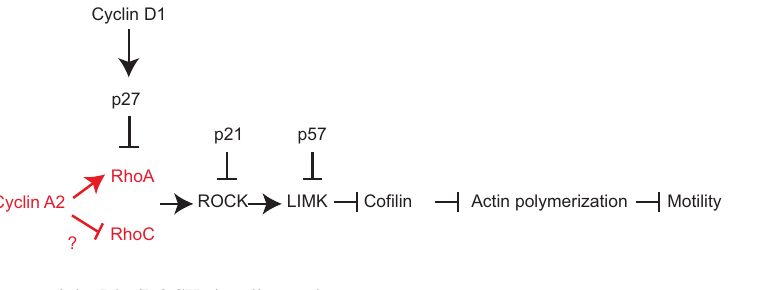
Figure 2 Cell cycle regulators and the Rho/ROCK signaling